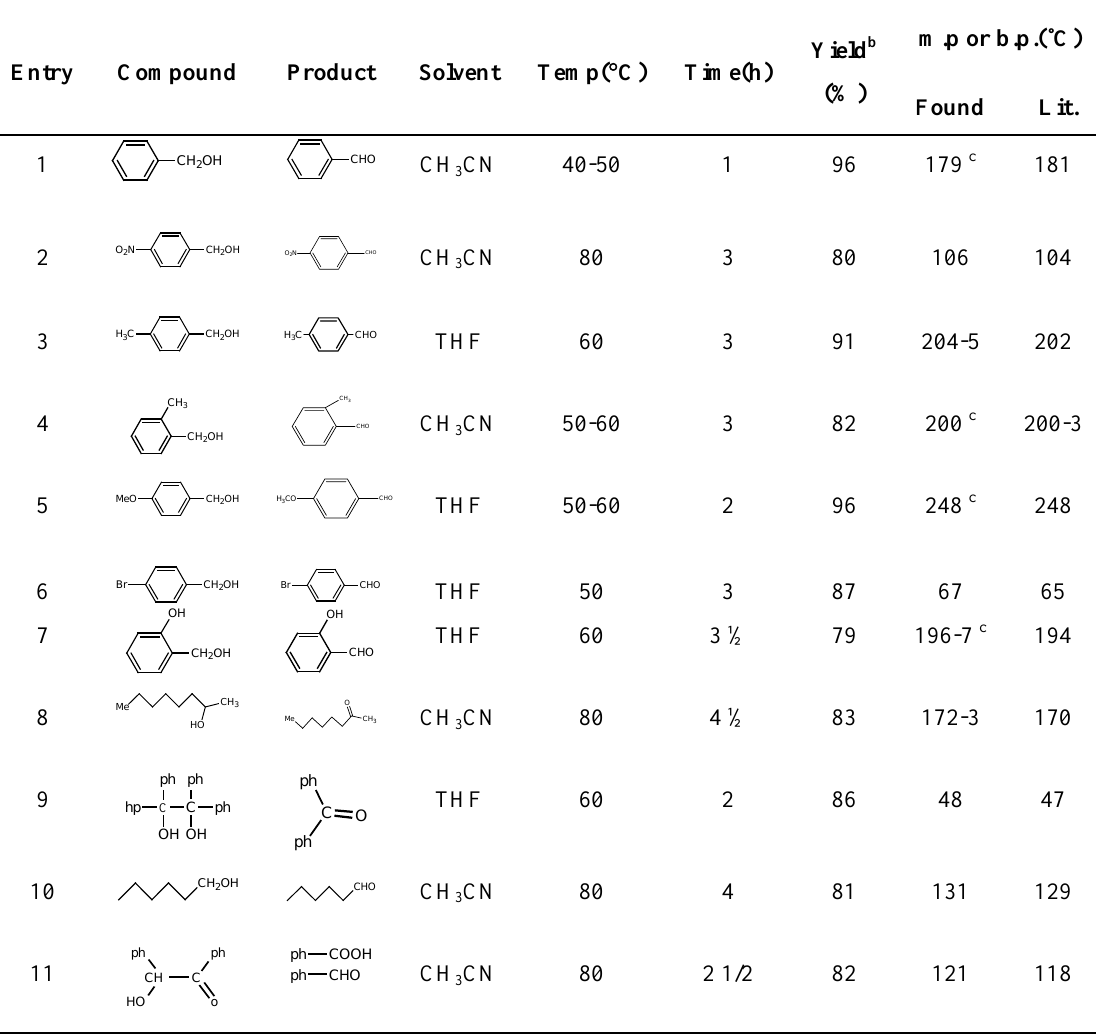
Table 1. Oxidations of alcohols to aldehydes and ketones with BTSC/H